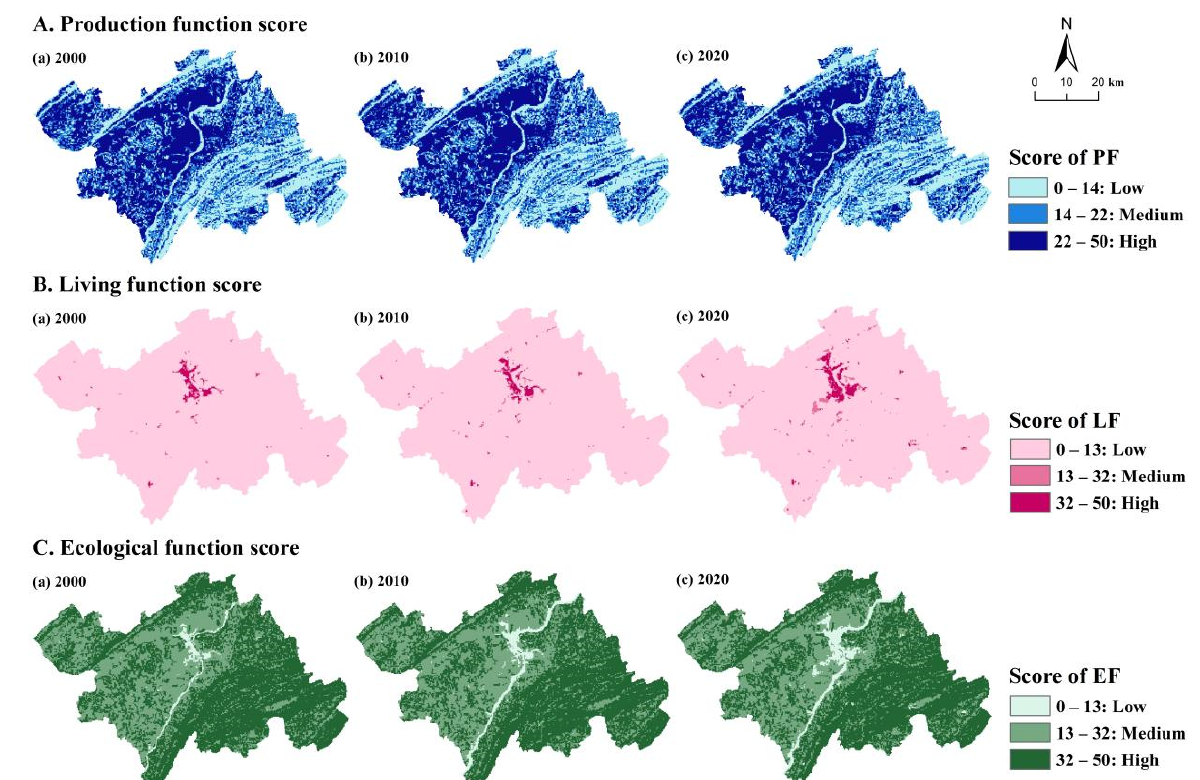
Figure 3. Spatial–temporal evolution of the PF(A), LF(B), and EF(C) from 2000 to 2020.